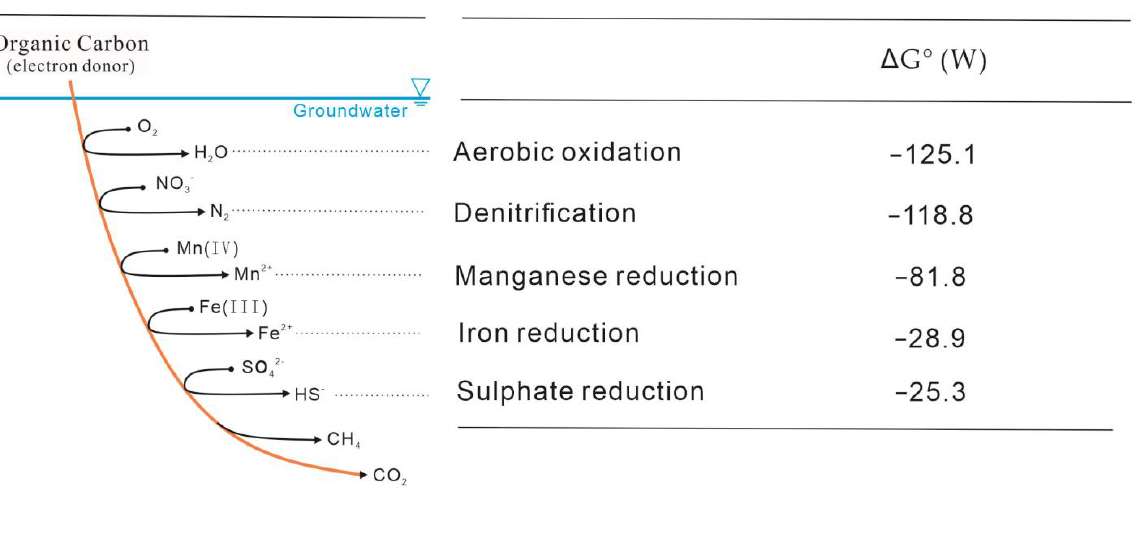
Figure 1. Electron acceptor thermodynamic sequence of organic carbon oxidation in saturated re- gions